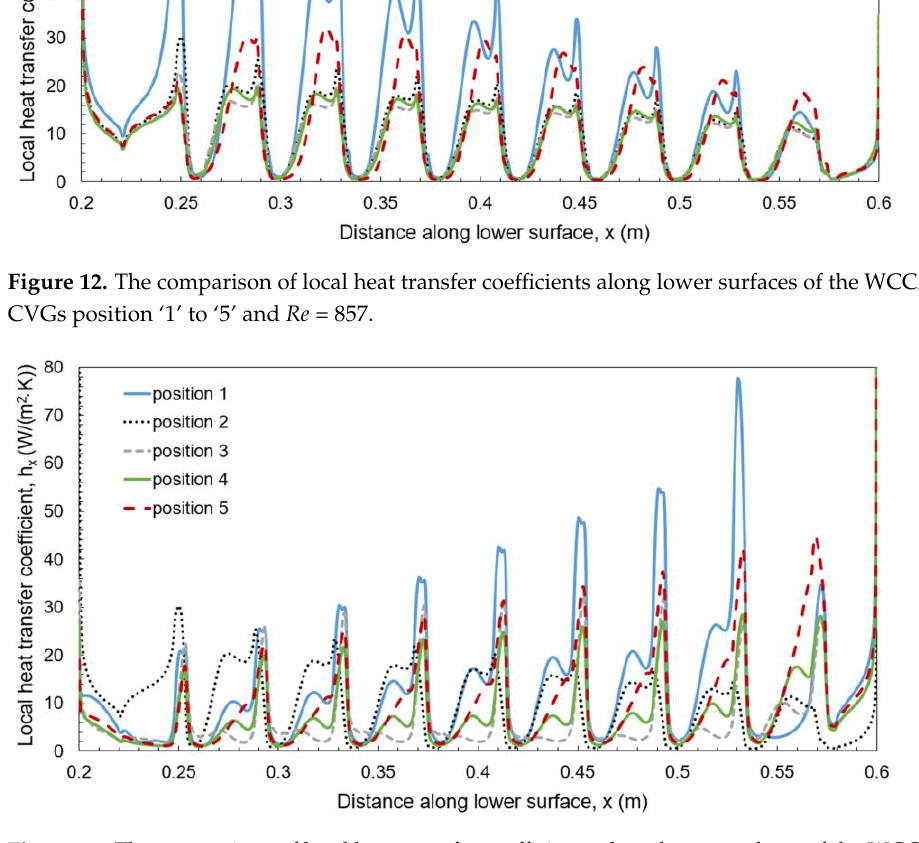
Figure 14. The temperature fields and velocity vectors of the WCCA15 (position ‘1’) for Re = 857 ( Q = 5 m 3 /h), ( a ) temperature fields along the channel, ( b ) velocity vectors along the channel.